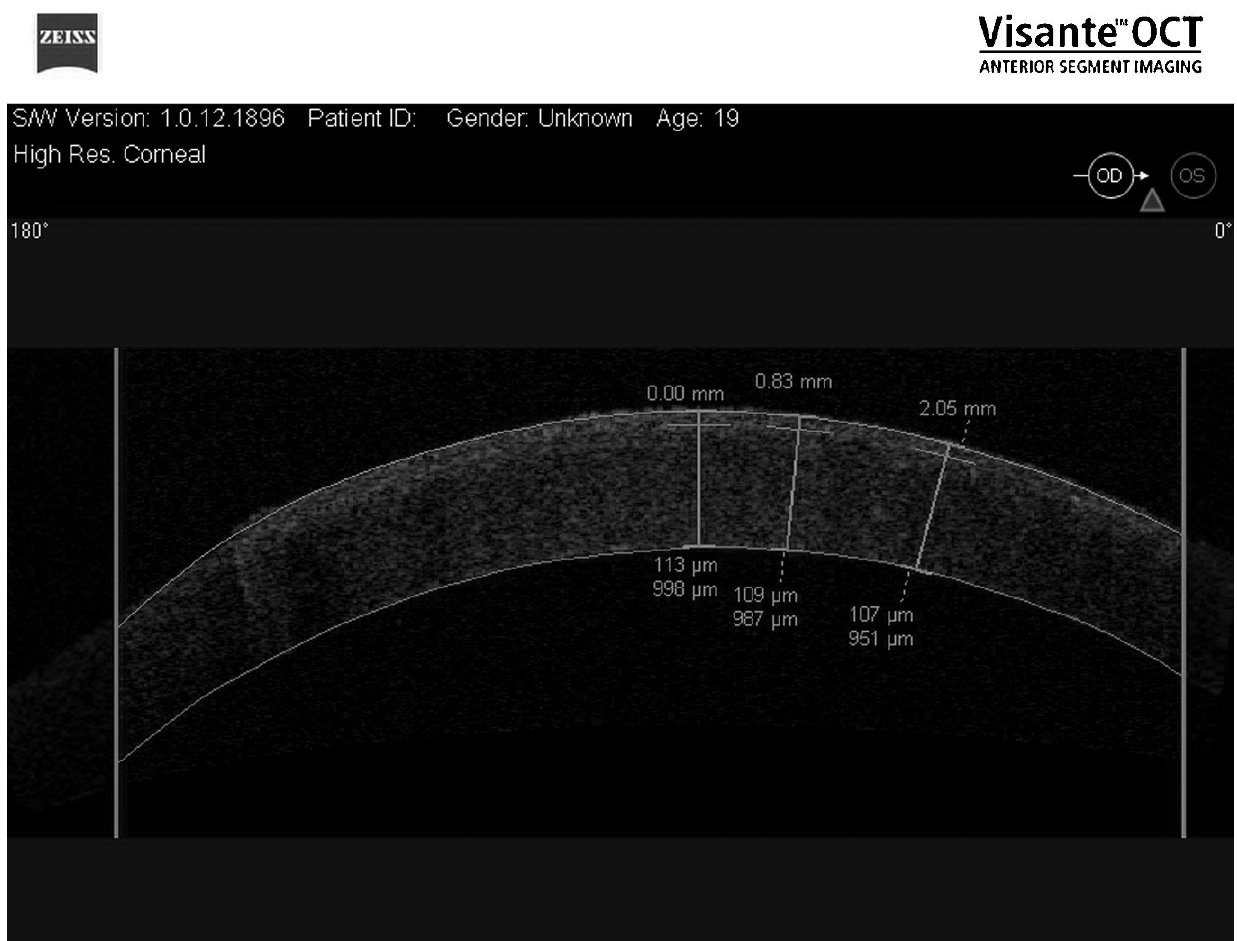
Figure 3 - OCT image of a thin flap created with the femtosecond laser.